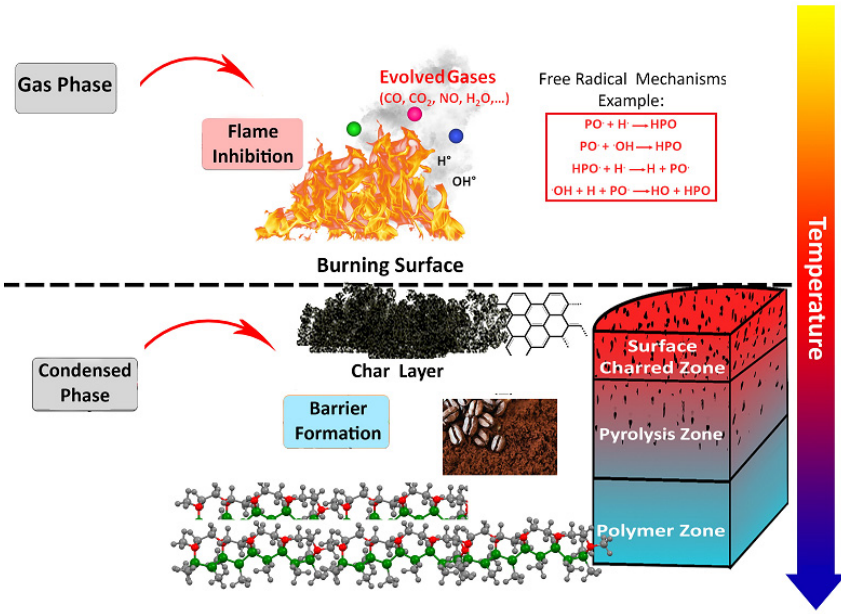
Figure 11. Possible mechanism of flame retardancy of sustainable coffee biowastes in epoxy.